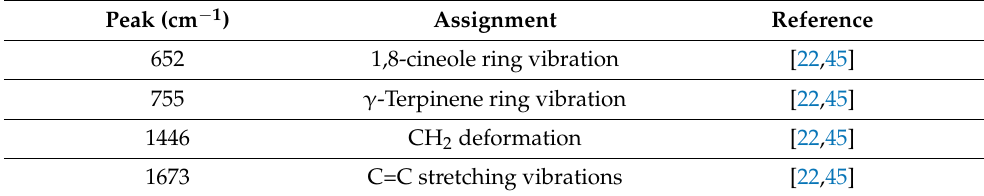
Table 3. Cardamom FT-Raman characteristic peaks and their respective